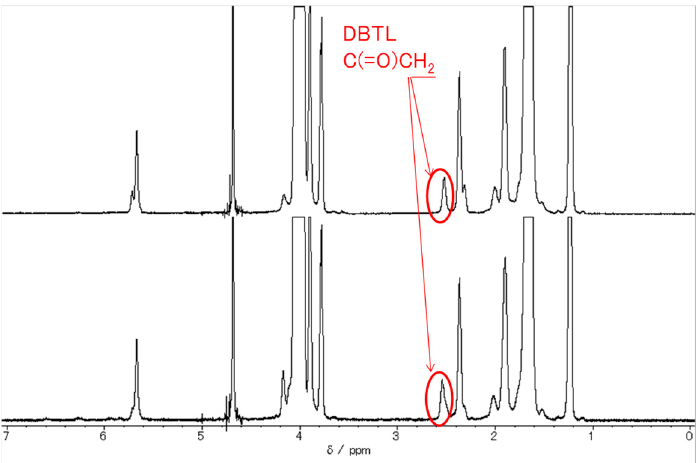
Figure 13. 1 H-NMR spectrum comparison of E212/DBTL (upper) and E230/DBTL (lower) at 70 °C .